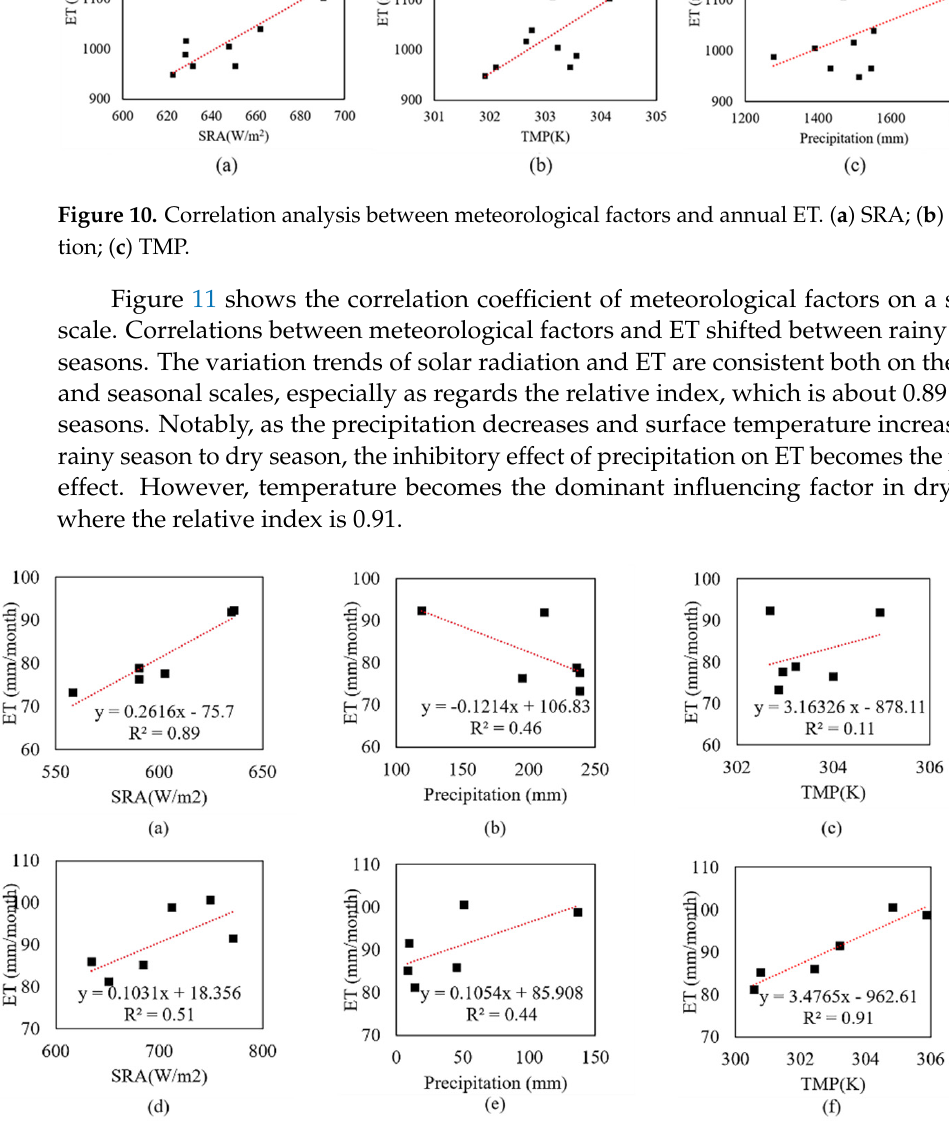
Figure 11. Correlation analysis between meteorological factors (SRA, precipitation and TMP) and monthly ET in the rainy season and the dry season.